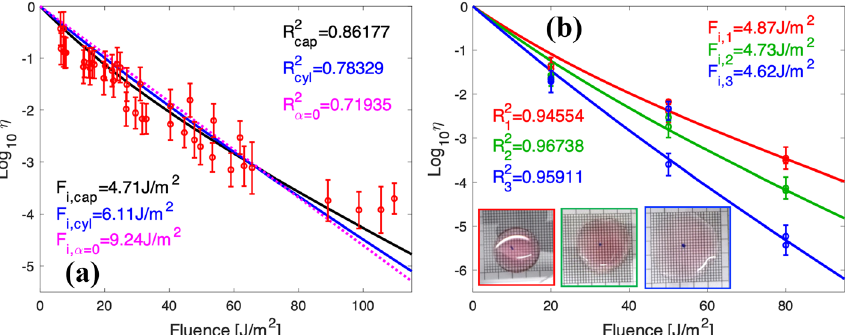
Figure 5. ( a ) Fitting of the data using the spherical cap model (in black) and the cylindrical model (in blue). The dashed magenta line corresponds with these two models for the case of a non-absorbing media ( α = 0 ). The values of the characteristic fluence, F i , are shown in the plot with the same color code. These fluences have been obtained changing the exposure time for an irradiance ∼ 0.7 W/m 2 (see Irradiation chamber section). ( b ) Fitting of three controlled experiments using drops of different heights with a fixed volume. Therefore, the height of the sample varies when changing the transversal size of the drop (see Table 1). The diameter of the drop increases as 2 a 1 = 16.9 mm (red), 2 a 2 = 19.2 mm (green), and 2 a 3 = 24.2 mm (blue). The value of the characteristic inactivation fluence is ∼ 4.7 J/m 2 . The error bars in plots ( a ) and ( b ) were obtained considering all uncertainty sources in the experiment. The inset shows three upper views of the drops framed with the same color code than the plots. The value of R 2 (see Eq. (15)) is also included within the plots to quantify the quality of the fitting. This fitting goodness parameter is larger in ( b ) due to the lower number of data points than in ( a